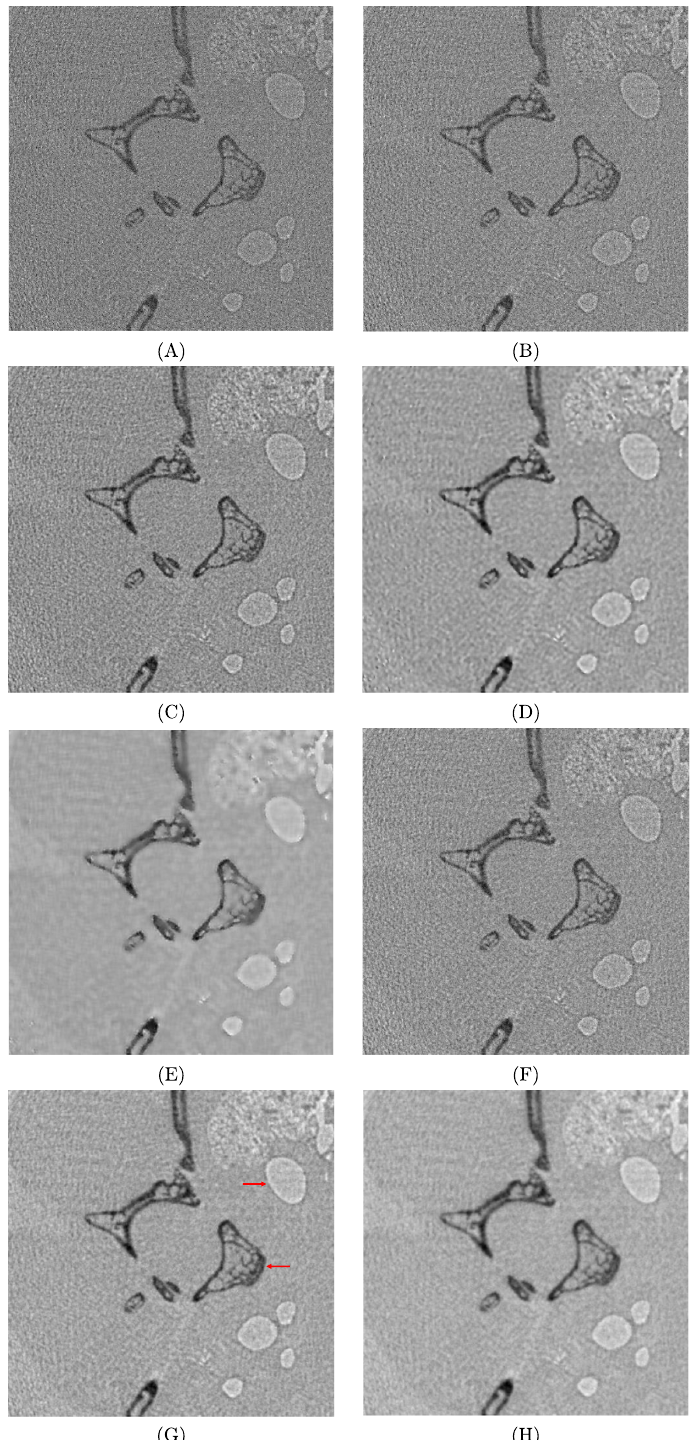
Fig 10. Sparse-view reconstructions with 180 projections from different methods. FBP with (A) ramp, (B) Shepp- Logan, or (C) Hann filter; FBP with Hann filter then Wiener noise-removal filtering with a window size of (D) 5 or (E) 10; BPWD-W with (F) σ = 1, (G) σ = 7, or (H) σ = 15.